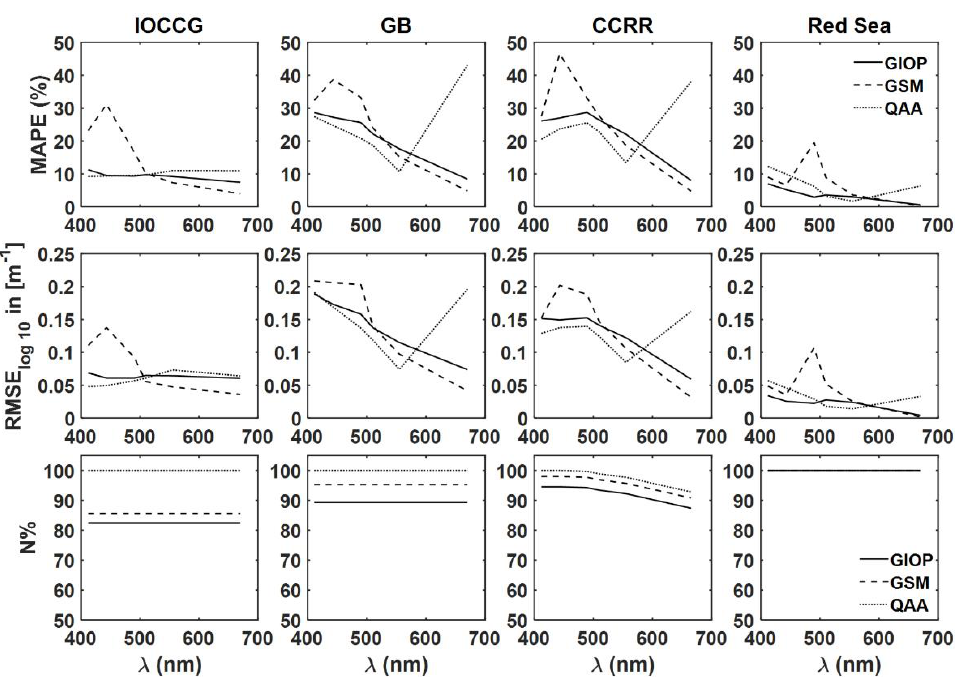
Figure 4. Comparing GIOP, GSM and QAA algorithms in the retrieval of a(λ) from measured or simulated spectral remote sensing reflectance, Rrs(λ) from IOCCG, GB, CCRR and Red Sea